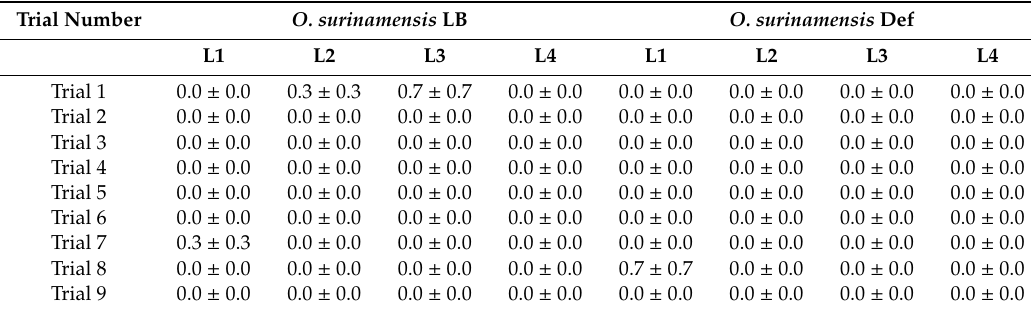
Table 3. Progeny production (mean number of adults ± SE / vial) in vials containing parental adults of two populations of O. surinamensis (LB, Def), with di ff erent susceptibility to phosphine, exposed to nitrogen in nine di ff erent trials (for conditions for each trial, see Table 1). For each trial, vials with insects were placed in four di ff erent locations (L1–L4, see Table